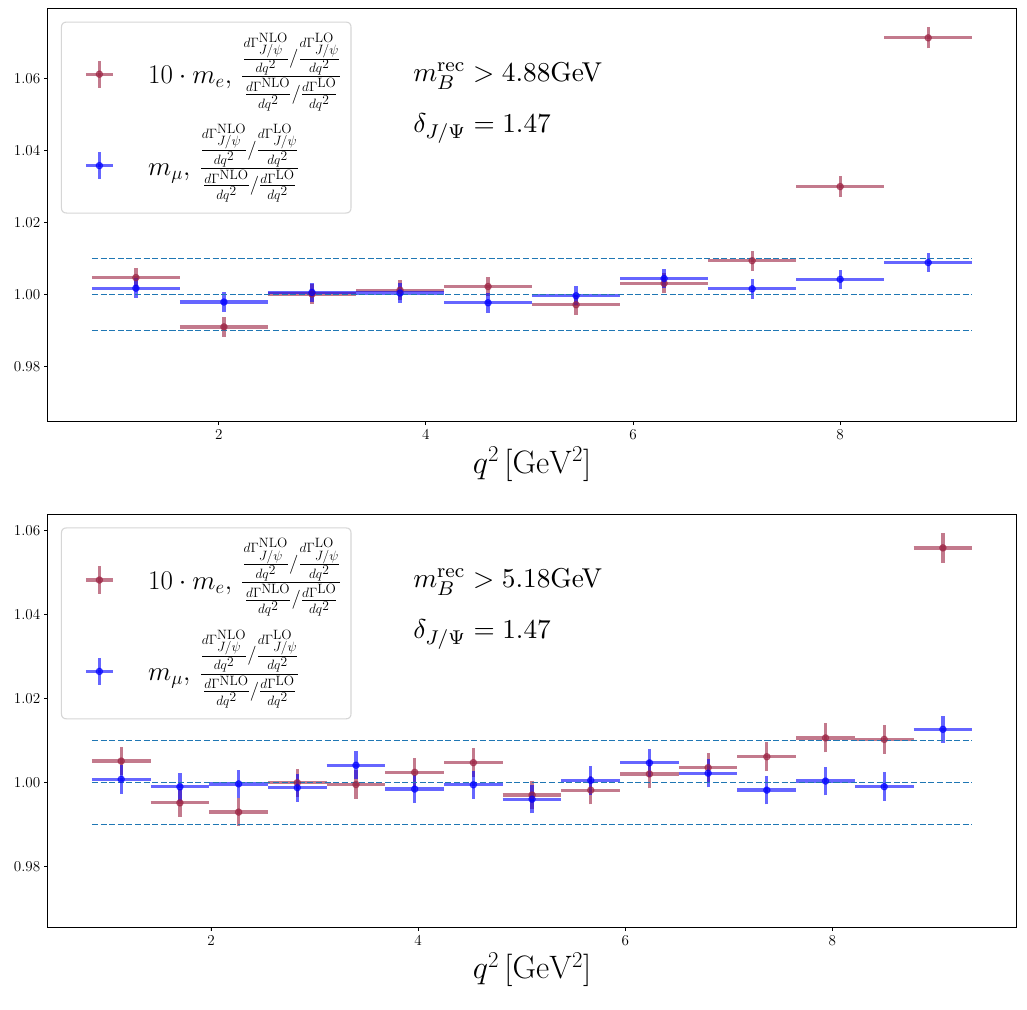
Figure 3 . Double ratio of the q 2 -spectrum, with and without the inclusion of interference effects induced by the J/ Ψ -resonance, for electron and muons, using the respective reference m rec in table 1. For numerical stability we use m The phase of the J/ Ψ amplitude, relative to the SD term, is set to δ